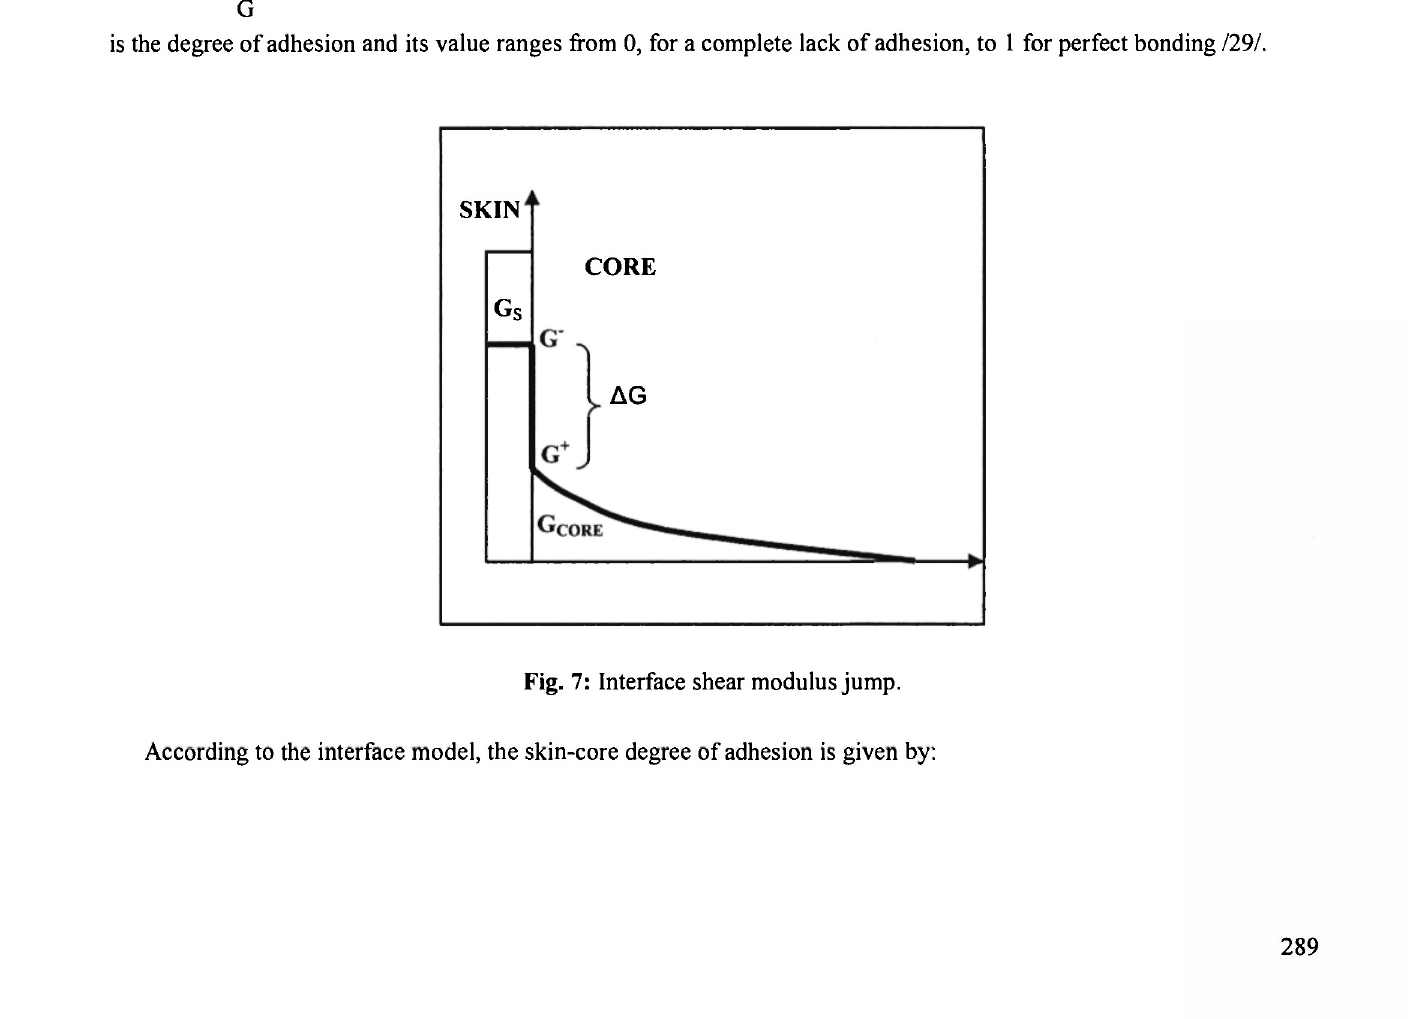
Fig. 7: Interface shear modulus